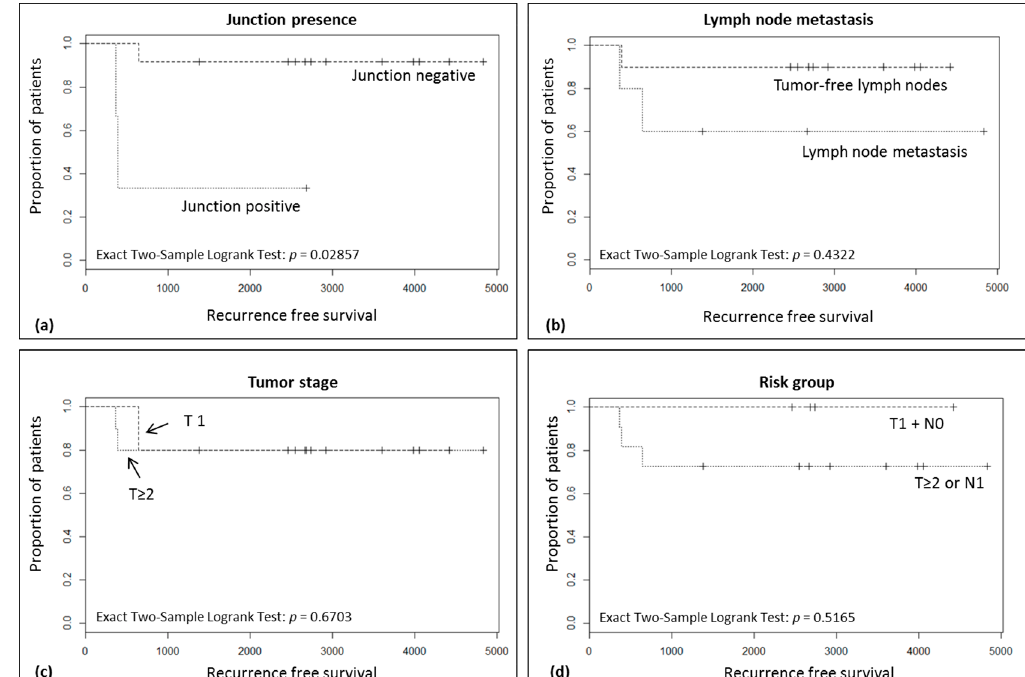
Figure 3. Kaplan Meier curves to assess the impact of ( a ) junction presence, ( b ) lymph node metastasis, ( c ) tumor stage and ( d ) the combined presence of risk factors on recurrence free survival. Censored subjects are indicated with a tick mark: (+).